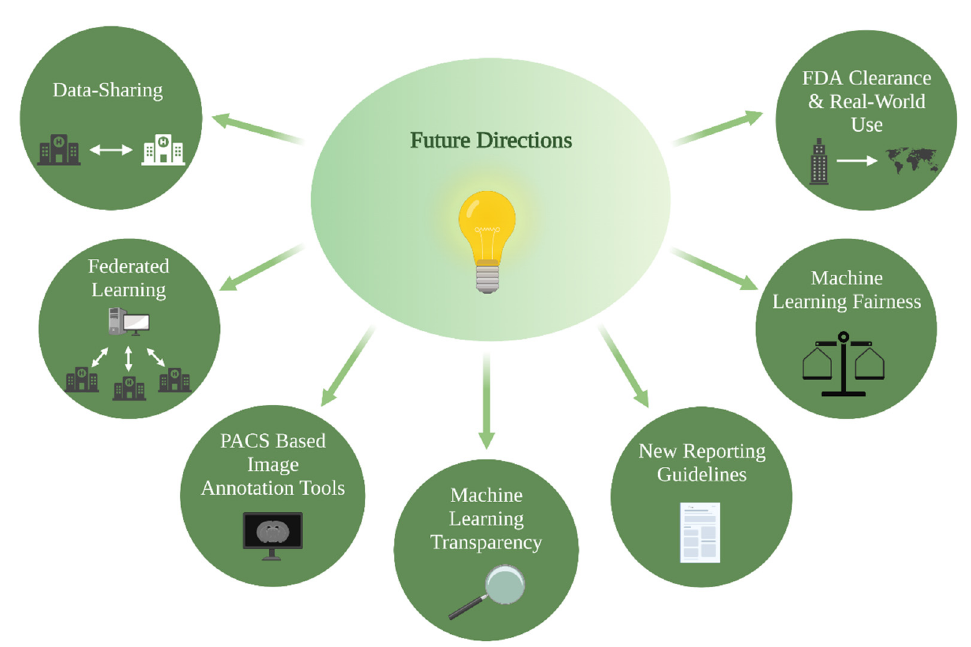
Figure 3. Future directions for clinical implementation of ML glioma grade prediction models, ML = machine learning.